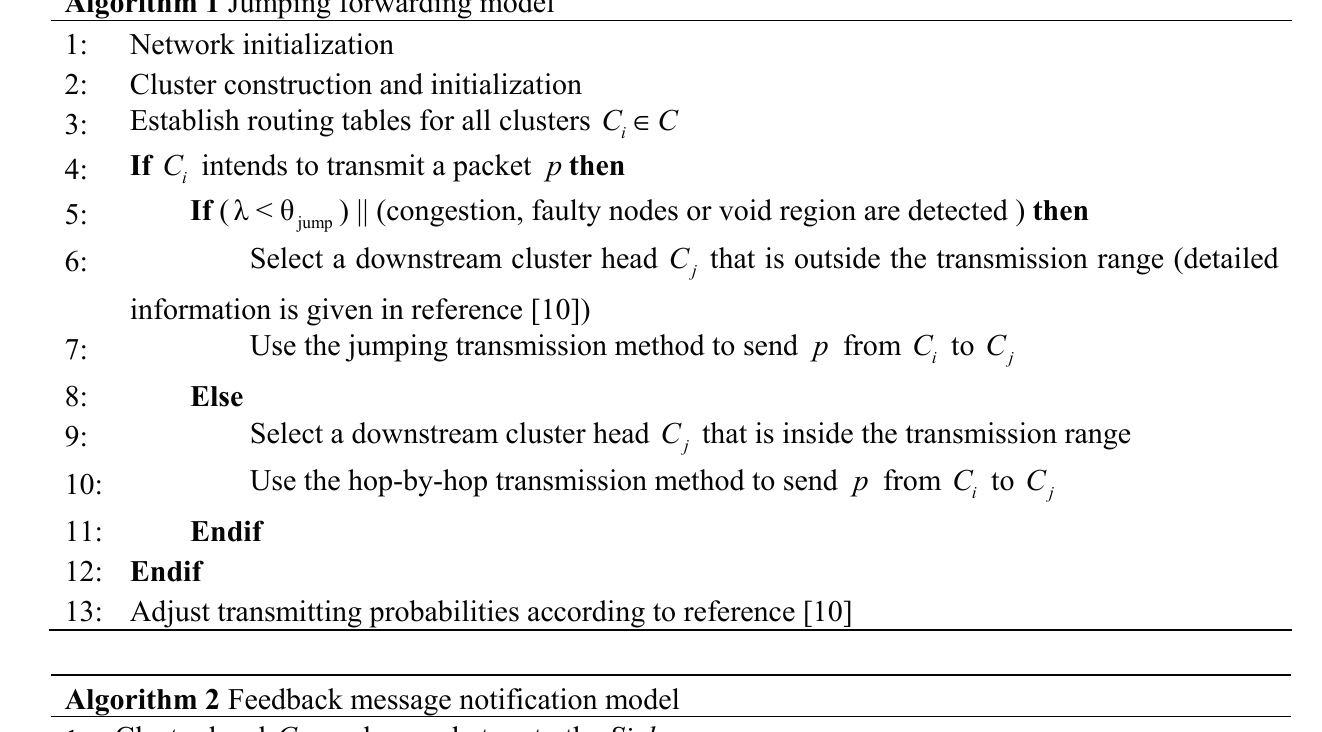
Algorithm 1 Jumping forwarding model